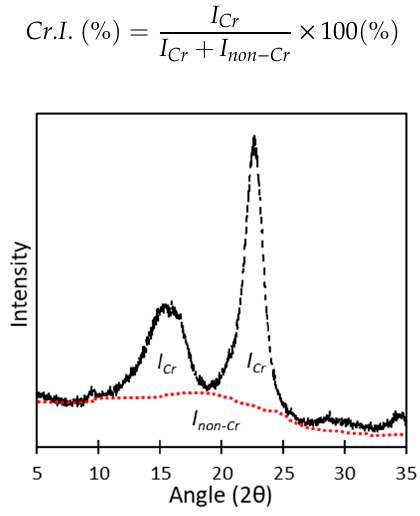
Figure 2. Calculation of crystallinity index. Take the sample “SA6345-2PN” as example.